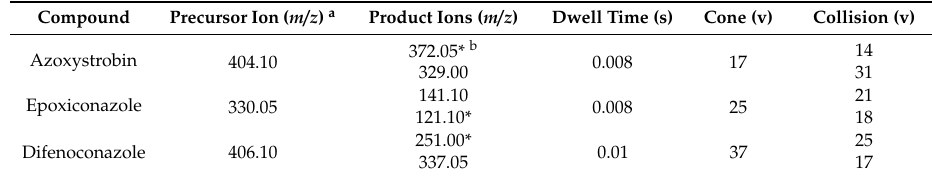
Table 2. Multiple reaction monitoring (MRM conditions) during the HPLC-MS / MS analyses of three pesticide residues.